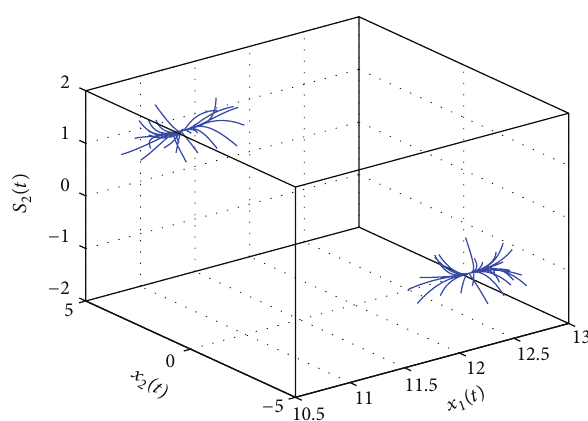
Figure 16: Phase plot of state variable (𝑥 1 ,𝑥 2 ,𝑆 2 ) 𝑇 in Example 2.